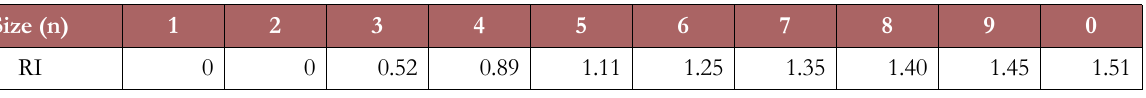
Table 2. The random consistency index (RI) based on Saaty